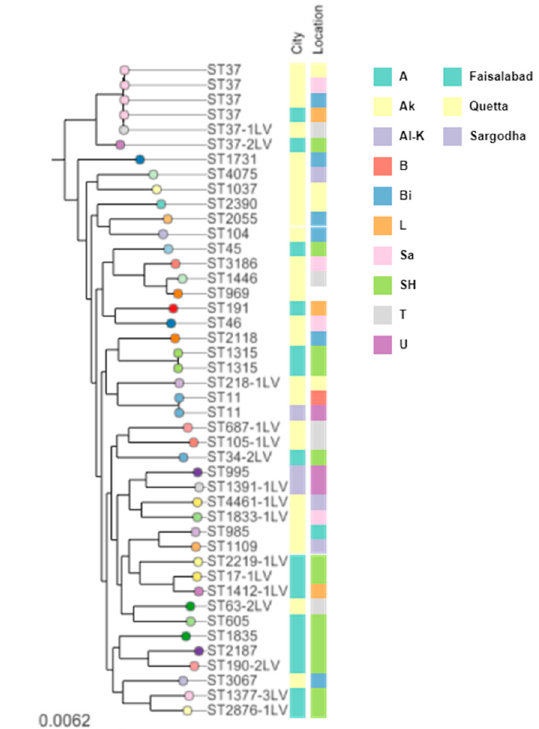
Figure 1. Sequence type distribution of K. pneumoniae among different dairy cattle farms. The location refers to the specific dairy farm. The data is available to explore via the Microreact project at https://microreact.org/project/iqM31fUDH173HKRxjpEVMi-whole-data-tree. For the exact format used in this figure, see https://microreact.org/project/7cjj9qFE8LbppJsRGXtk8f-st-distributionkp.